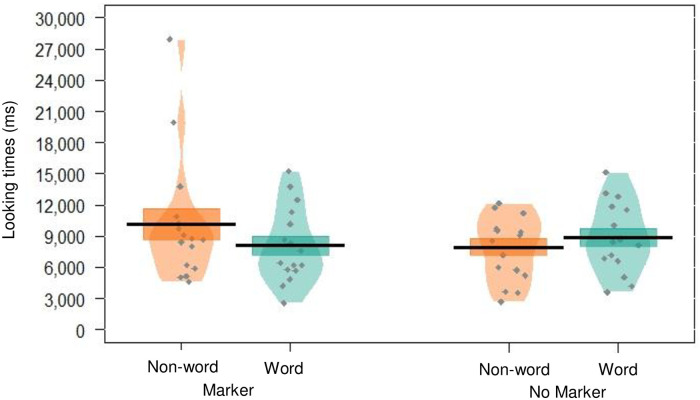
Pirate plot depicting the (raw) mean looking times to words and non-words, given for each condition.Black lines indicate the mean, and the coloured blocks indicate SE. The distribution of looking times is given for each group, with individual data points in grey. We note that subsequent supplementary exploratory analysis found that infants in the No Marker group were not homogeneous in their looking preferences–thus this visualisation combines data from two opposing preferences; a novelty preference (children with High CDI scores) and a familiarity preference (children with Low CDI scores); see Fig 5).